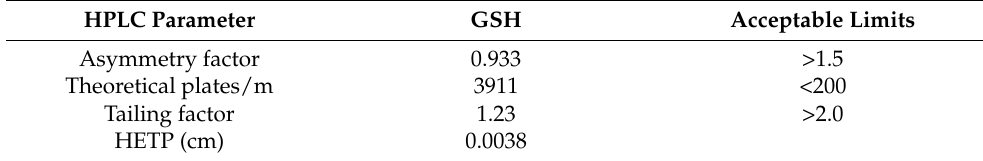
Table 5. System Suitability Parameters for the Determination of GSH by the HPLC